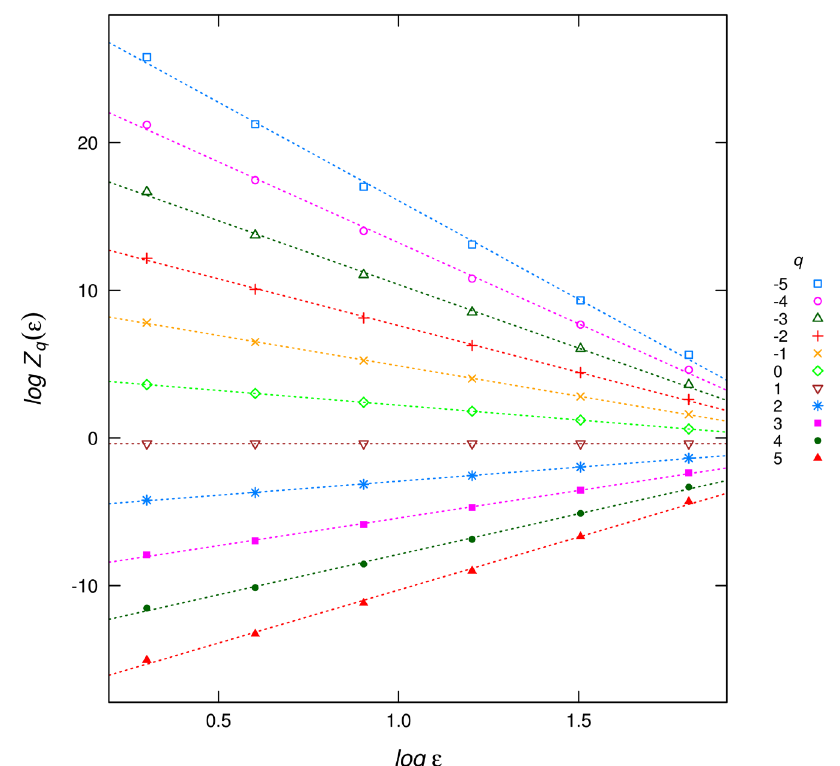
Figure 1. Plot of the linear regressions for different q used to estimate the D